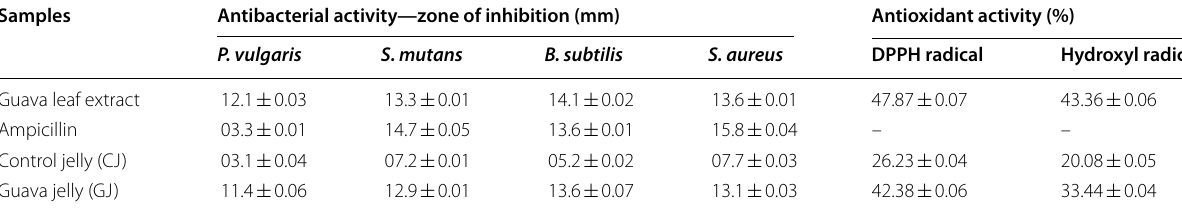
Data is expressed as mean